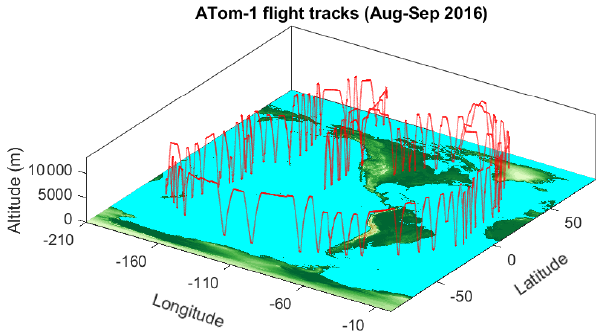
Figure 2. Flight tracks during the ATom1 campaign (red lines) car- ried out from August to September 2016, covering altitudes from 200m to 12km over the Pacific and Atlantic